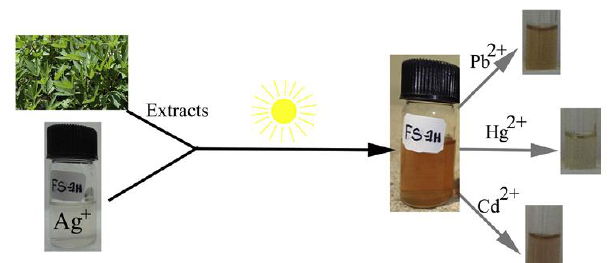
Fig. 14. Bio-functionality of green synthesized AgNPs from Hibiscus Sabdariffa plant extracts were successfully utilized for selective colorimetric sensing of potentially health and environmentally toxic metal ions such as Hg 2+ , Cd 2+ and Pb 2+ in aqueous solution. Re- printed with permission from ref.89. Copy right 2017 Elsevier.